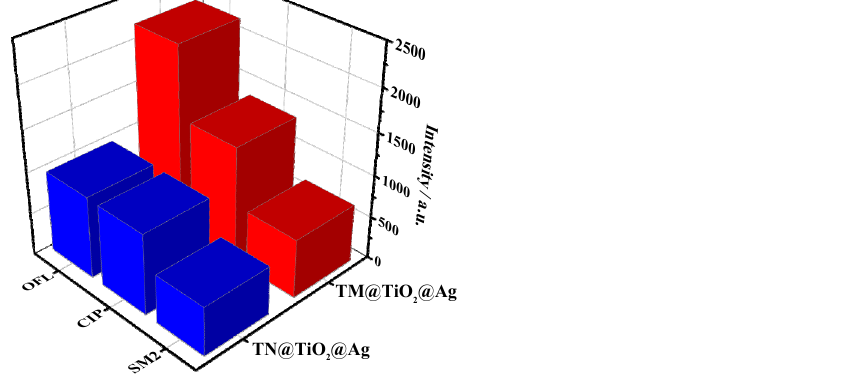
Figure 6. Selectivity of TM@TiO 2 @Ag and TN@TiO 2 @Ag for different compounds at the same concentration of 10 − 5 M.